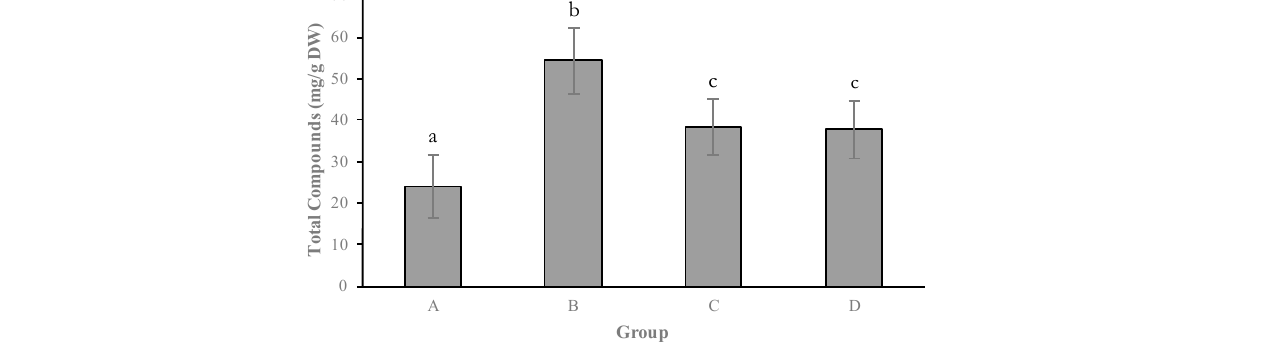
Figure 2. The groups denote to order of UPGMA clustering for 100 individual plants. Amount of Total Compounds (mg/g DW) in different groups. a, b, c: differences in small letters indicate significant differences between groups ( p < 0.05). Bars indicate the standard error.